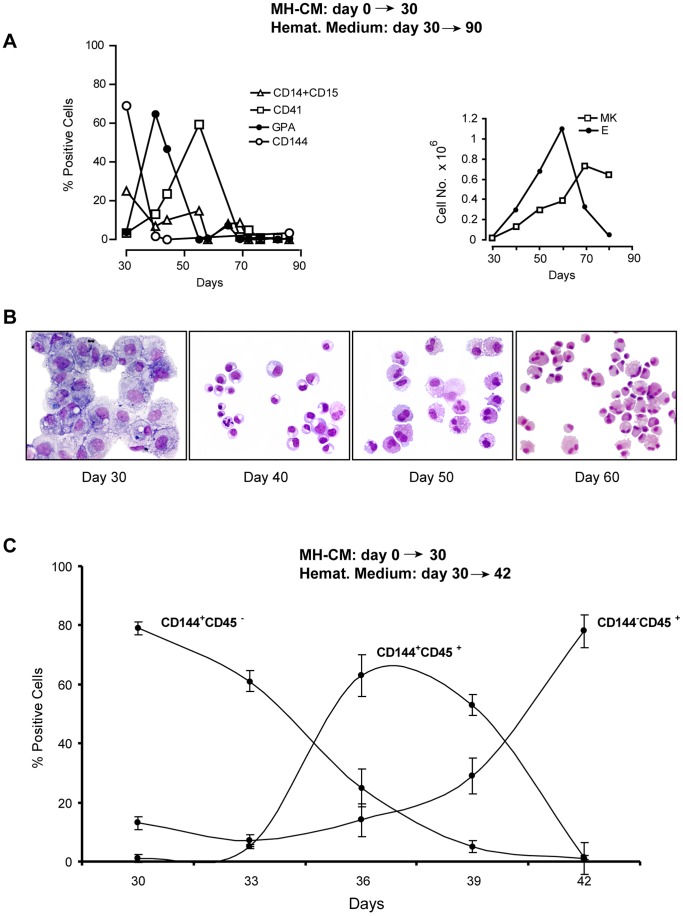
Immunophenotypic and morphological analysis of adherent ECs progeny following transfer into haematopoietic culture.A- Left: Time course FACS analysis of adherent cells generated by CD34+ cells cultured in MH-CM and then transferred, at day 30, to haematopoietic medium and characterized for lineage -specific antigen expression. A representative experiment out of 5 is shown. - Right: Growth curve of erythroid (E) and megakaryocytic (Mk) cells generated from the culture of day- 30 adherent cells in haematopoietic medium. A representative experiment out of 5 is shown. B- Morphological analysis of adherent cells generated by CD34+ cells cultured in MH-CM for 30 days, then transferred to haematopoietic medium and grown for additional days (day 30 = day 0 in haematopoietic medium, day 40 = day 10 in haematopoietic medium, day 50 = day 20 in haematopoietic medium, day 60 = day 30 in haematopoietic medium). At day 40, the large majority of cells had a morphology typical of the erythroid lineage elements at various stages of maturation. At later days of culture (day 50 and 60), erythroid cells were replaced by a cell population with a morphology compatible with the cord blood derived megakaryocytes (i.e. showing limited capacity of polyploidization). Pictures of a representative experiment out of 3 are shown. C- CD144 and CD45 expression analysis of adherent cells generated by CD34+ cells cultured in MH-CM for 30 days, then transferred to haematopoietic medium (i.e. day 33 = day 3 in haematopoietic medium, day 36 = day 6 in haematopoietic medium and so on). The percentage of CD144+45−, CD144+45+ and CD144−45+ cells from 8 independent experiments is reported (mean values ±SEM ).